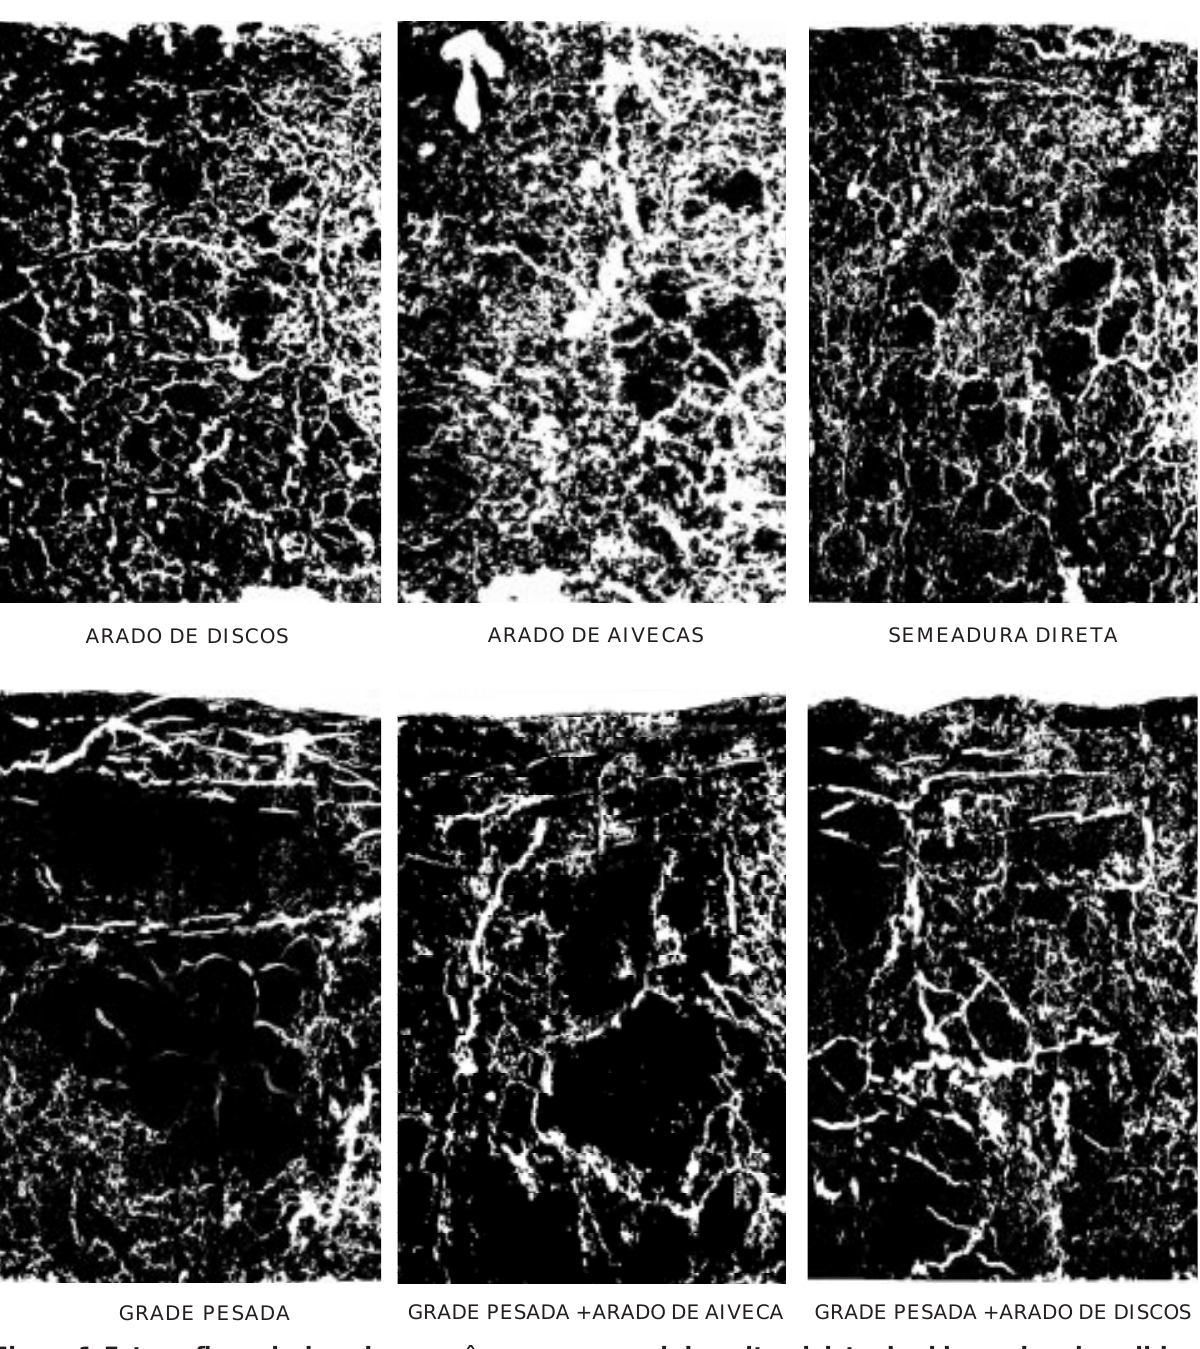
Figura 1. Fotografias selecionadas em câmara escura sob luz ultravioleta dos blocos de solo polidos, evidenciando a porosidade em branco e a matriz do solo em